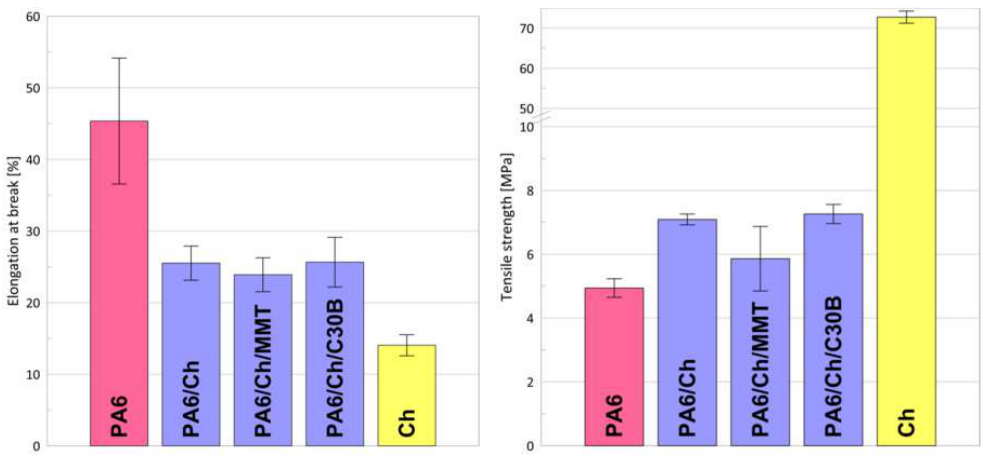
Figure 7. Elongation at break and tensile strength of PA6 support, pristine chitosan and composite chitosan membranes.